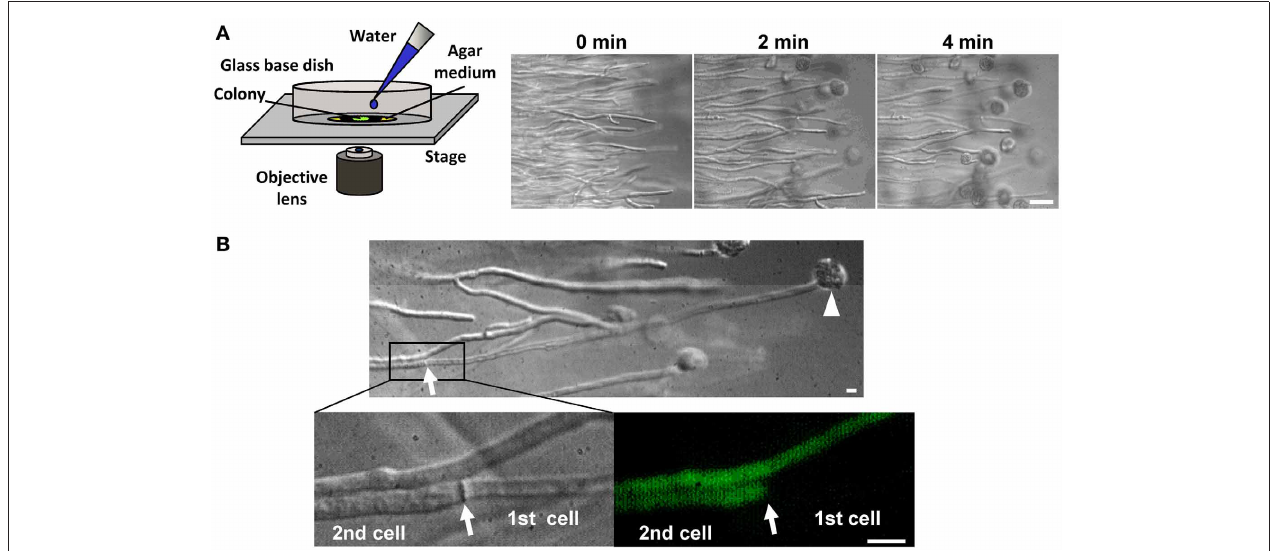
FIGURE 1 | Hyphal tip bursting upon hypotonic shock in the filamentous fungus A. oryzae . (A) Time-lapse observation of hyphal tip bursting upon hypotonic shock. Hyphal tips at the edge of a colony grown on agar medium were observed by DIC microscopy before and after flooding hyphae with water. Bar: 50 μ m. (B) Excessive loss of cytoplasmic constituents is